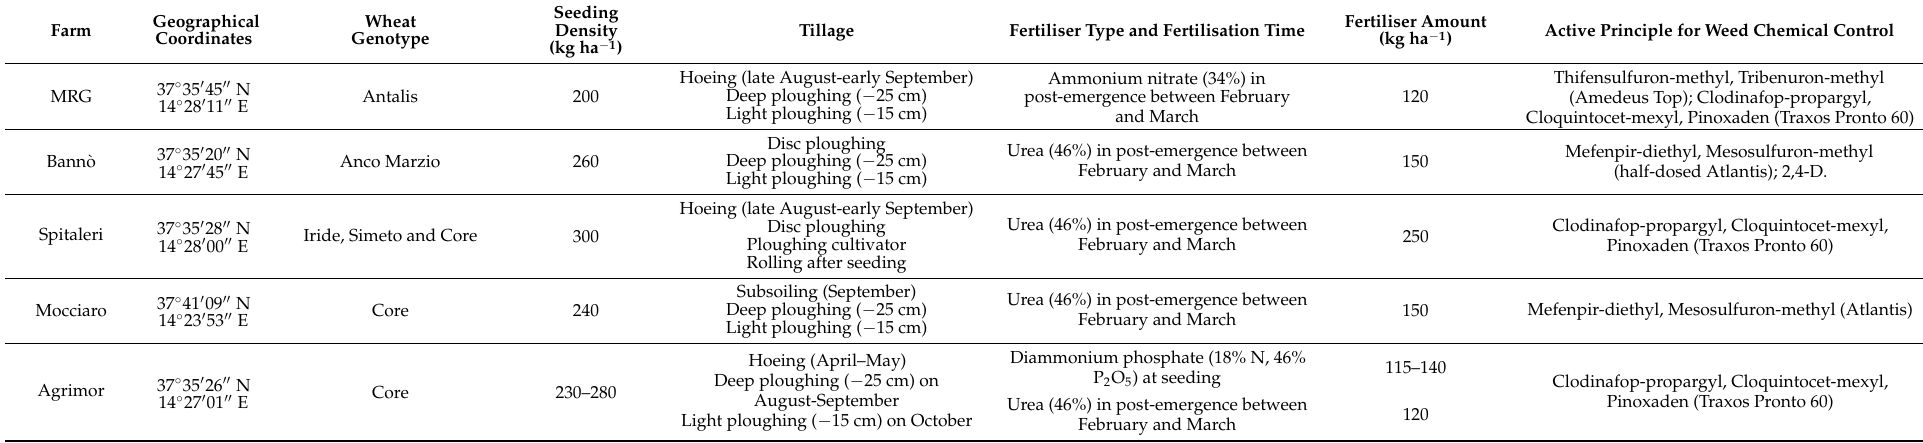
Table 6. Geographical coordinates and agronomic management of the 5 farms belonging to the MOD group.